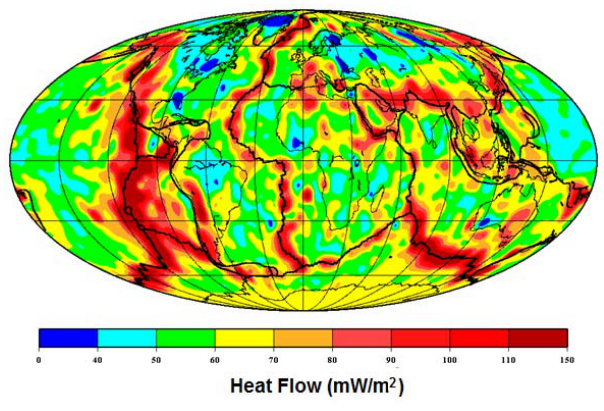
Fig. 2. Global heat flow map derived from observational data (Vieira and Hamza, 2010) and estimated values based on heat flow-age rela- tion (Hamza, 1967; Polyak and Smirnov, 1968; Hamza and Verma,